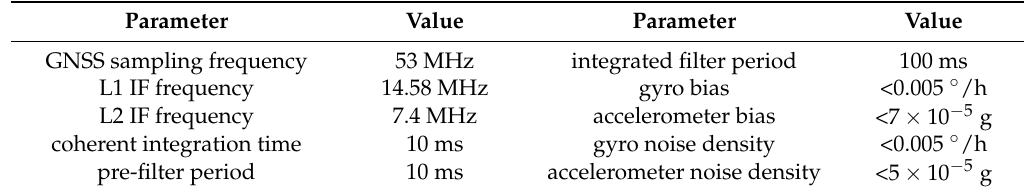
Table 3. Parameters defined in the system.